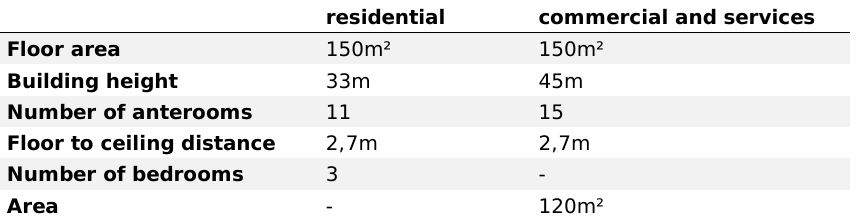
Table 1. Parameters used on the simulations.